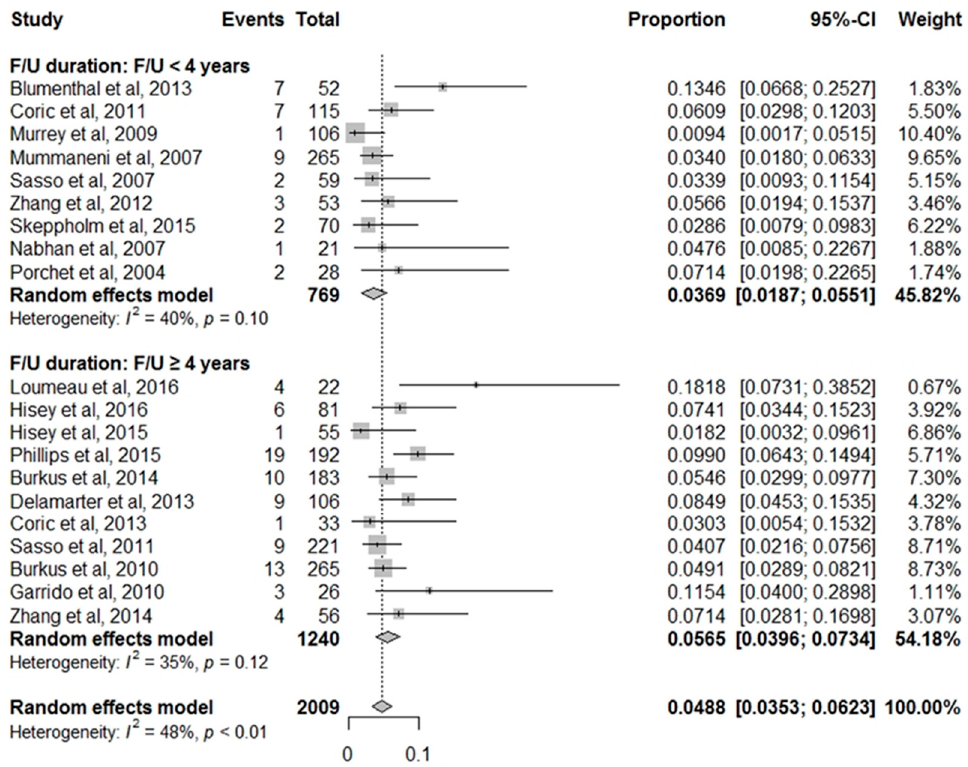
Figure 3. Forest plot comparing cASP that underwent surgery by follow-up duration.